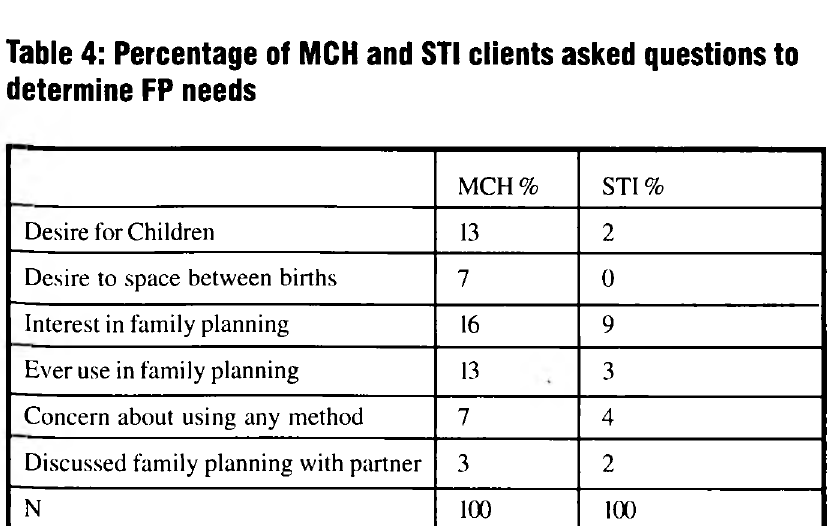
Table 4: Percentage of M CH and STI clients asked questions to determine FP needs